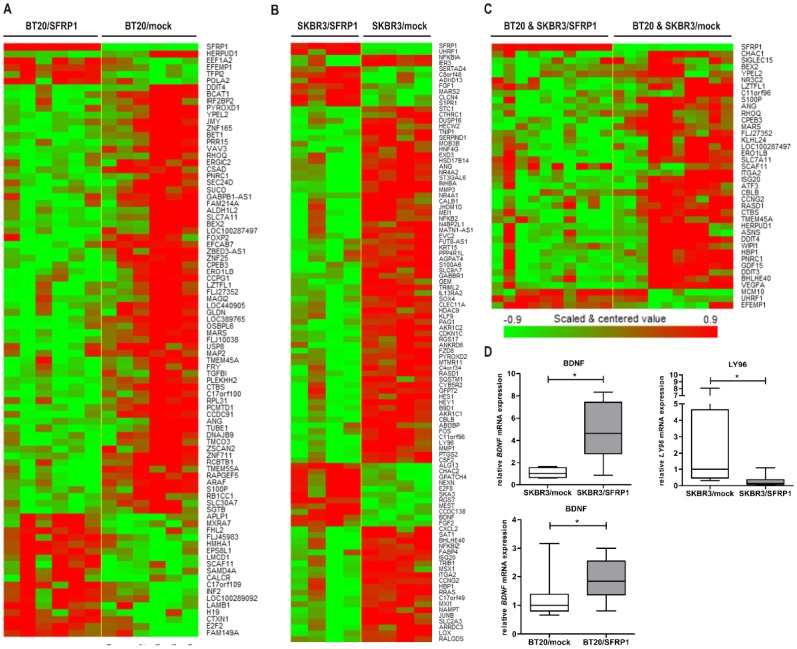
Microarray analysis from stable transfected cell lines BT20 and SKBR3.Genes represented have a p value of 0.05 or less and are regulated at least ±2-fold. (A) 87 differentially expressed genes were found by comparing BT20/SFRP1 and BT20/mock cells. (B) Comparison of SKBR3/SFRP1 and SKBR3/mock cells revealed 104 differentially expressed genes. (C) By applying class comparison between SFRP1 clones (BT20 and SKBR3) and mock clones (BT20 and SKBR3) 40 differentially expressed genes were discovered. (D) Validation of SFRP1 target genes in SKBR3 and BT20 model system. Semi-quantitative real-time PCR was performed for each target gene in the particular in vitro model. BDNF mRNA levels increased in SKBR3/SFRP1 clones compared to the mock controls (p<0.05). In contrast LY96 mRNA was up-regulated in SKBR3 mock clones (p<0.05). BT20 cells showed an increase of BDNF mRNA levels after SFRP1 re-expression (p<0.05).